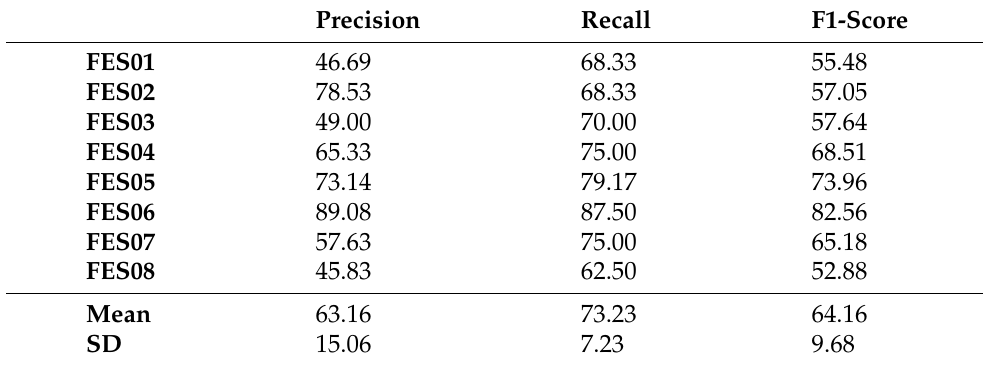
Table 3. Classifier performance (in %) of FES group without optimal